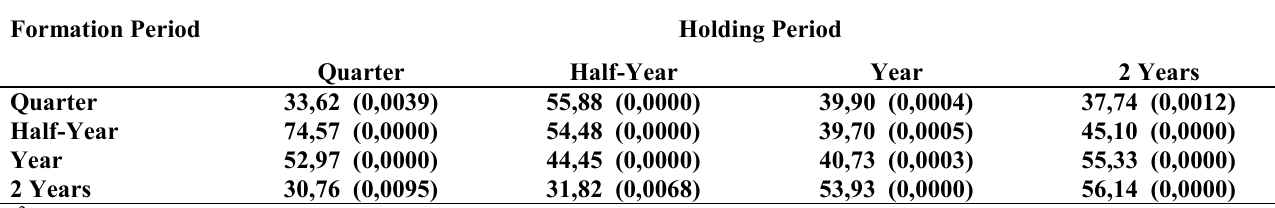
Table 1: Results of the quartile summary tables for general equity funds for the different formation and holding periods